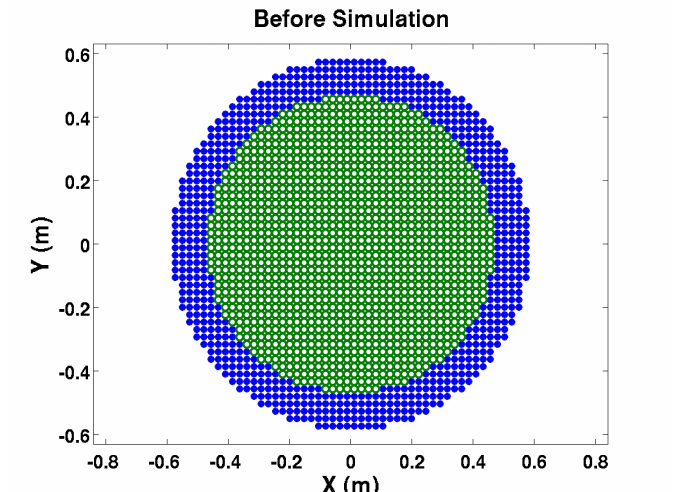
Figure 6. The pressure vessel, at the start of the simulation. Green circles represent water particles, and blue dots represent steel